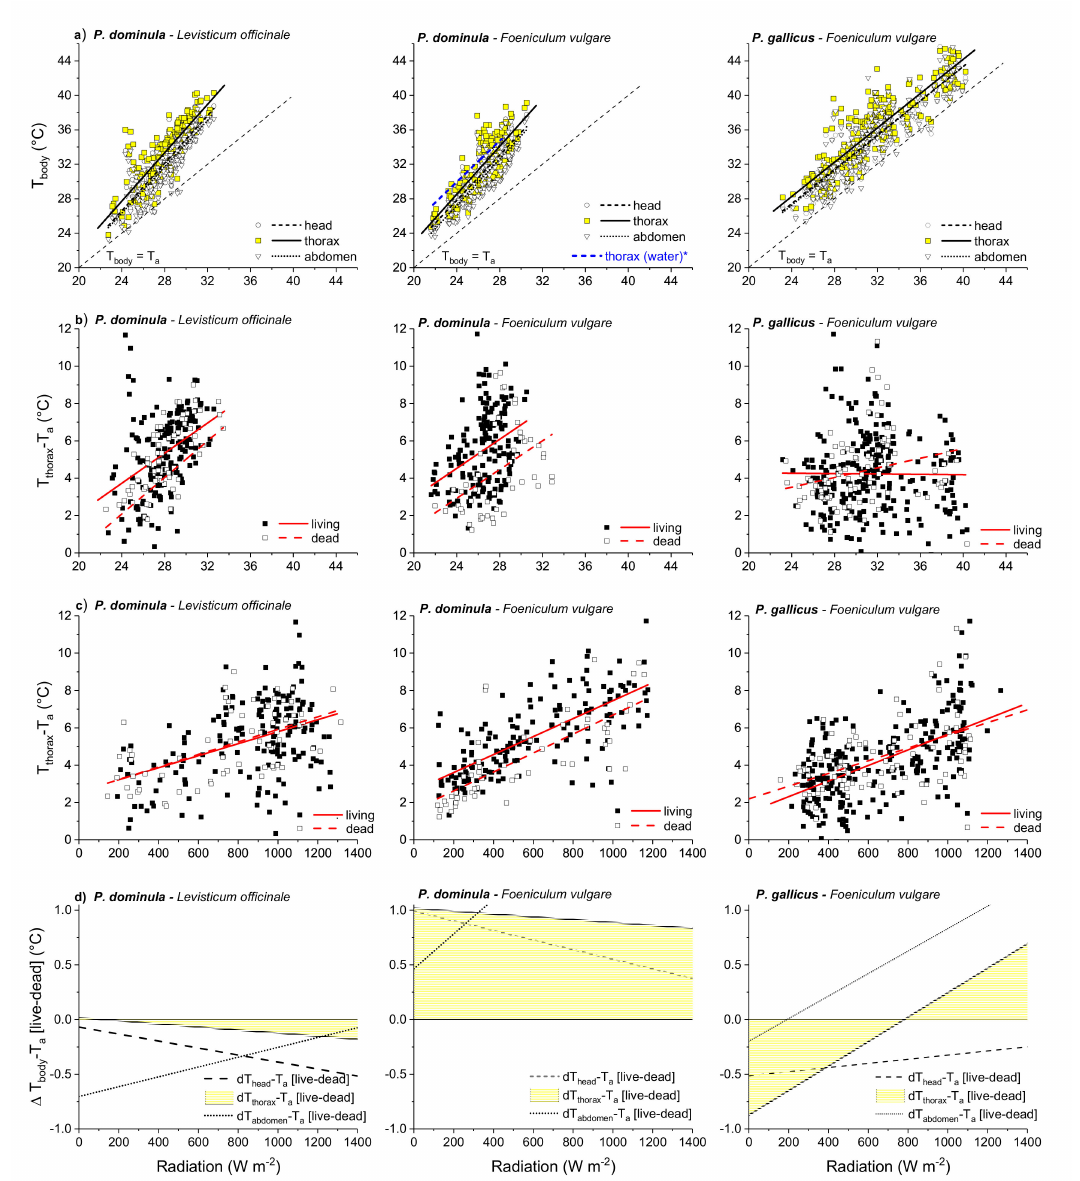
Figure 3. Body temperature ( a ), thorax temperature excess ( b and c ), and degree of endothermy ( d ) in dependence on environmental parameters, of foraging Polistes dominula and Polistes gallicus on lovage and fennel. T a = ambient temperature 1 cm beside the